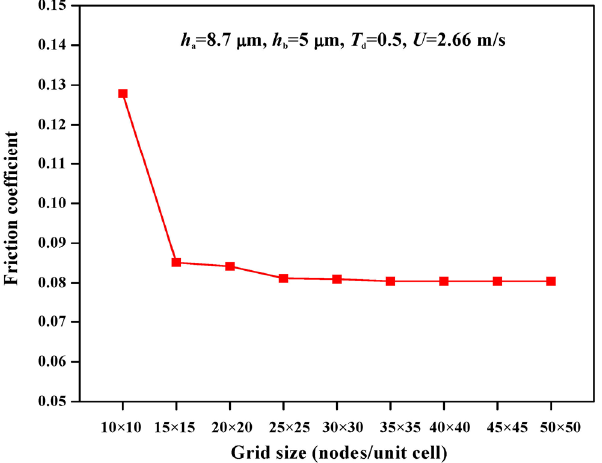
Fig. 3 Effect of grid size on friction